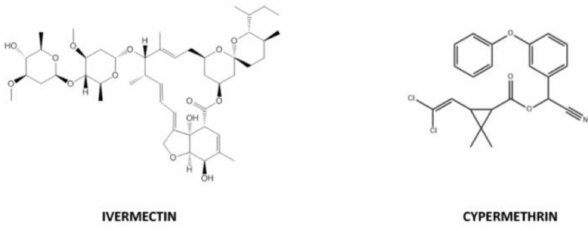
Figure 1. Chemical structures of ivermectin and